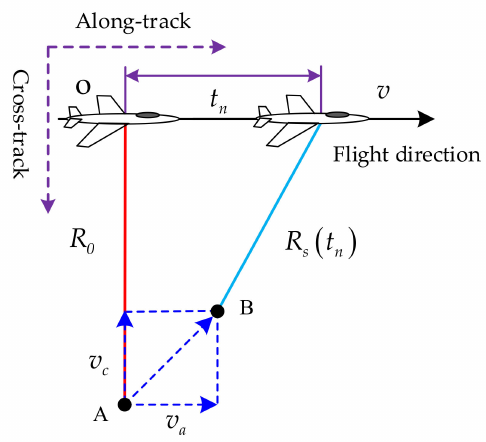
Figure 1. Motion geometry configuration between the synthetic aperture radar (SAR) platform and moving target on a slant-rang